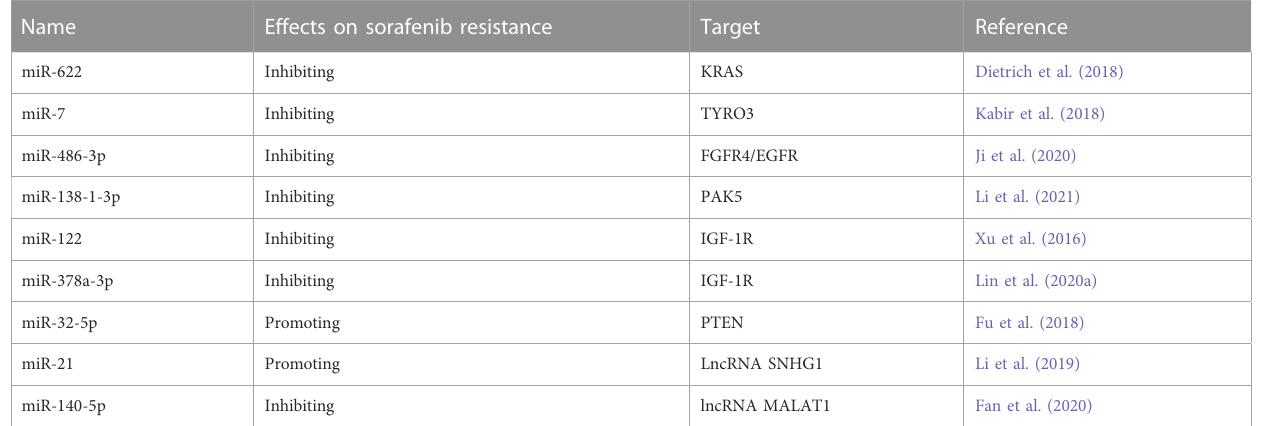
TABLE 2 Previous studies that show the involvement of miRNAs in sorafenib resistance in HCC.